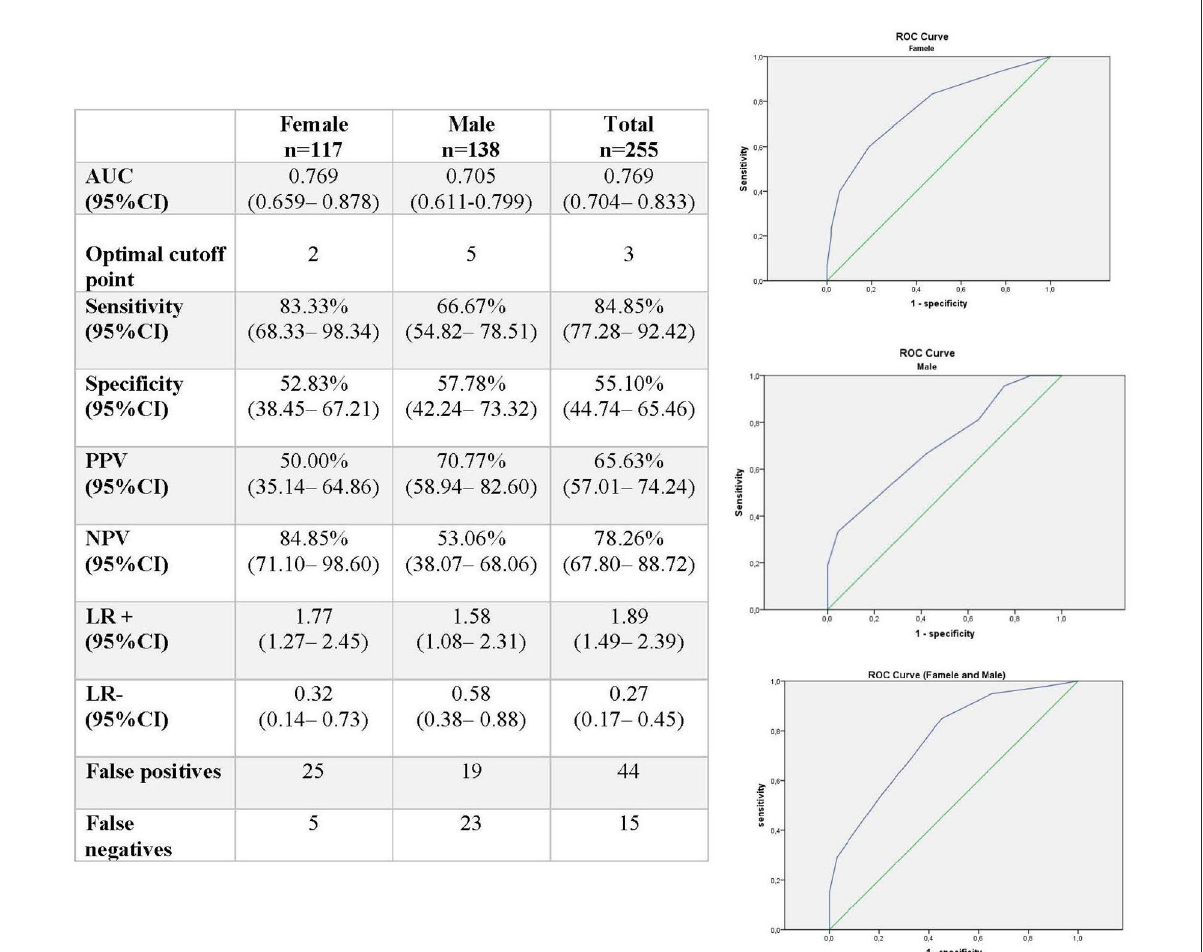
FIGURE3 Criterion validity of the STOP-Bang questionnaire for the screening for moderate/severe apneas (Apnea-Hypopnea Index [AHI] > 15). AUC, area under the curve; 95% CI, 95% confidence interval; LR, likelihood ratio; NPV, negative predictive value; PPV, positive predictive value.